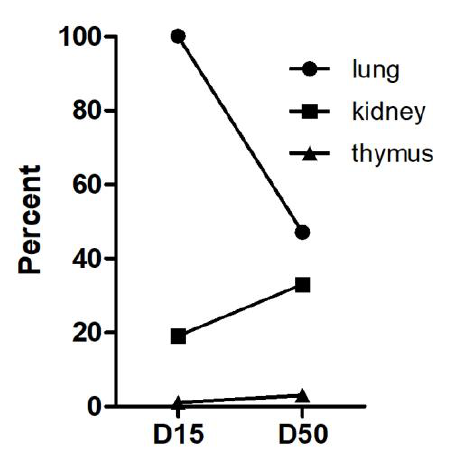
Figure 4. Detection of Luc + mASCs on day 15 (D15, n = 4) and on day 50 (D50, n = 1) after transplantation in Atm − / − mice. Graph shows fold Luc + expression in lung, kidney, and thymus at days 15 and 50 in relation to Luc + expression in the lung at day 15 (quantitative analysis of the relative Luc-mRNA amounts (percent of signal, lung D15 = 100%)).